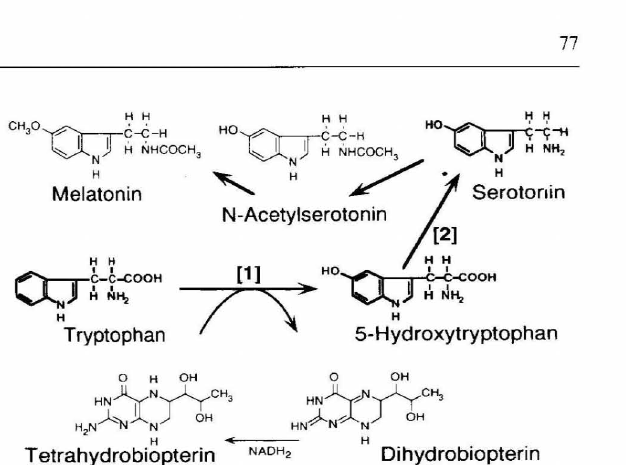
Figure 1. Biosynthetic pathway of serotonin (SHT) and mela tonin: Serotonin (SHT) is synthesized in a two step reaction: the first is catalyzed by [lJ tryptophan hydroxylase and the second by [2J aromatic L-amino acid decarboxylase. NSD lOSS, kan inhibitor of the latter enzyme, allows for accumula tion of S-hydroxytryptophan (SHTP) which serves as an indi cator of the intracellular activity of tryptophan